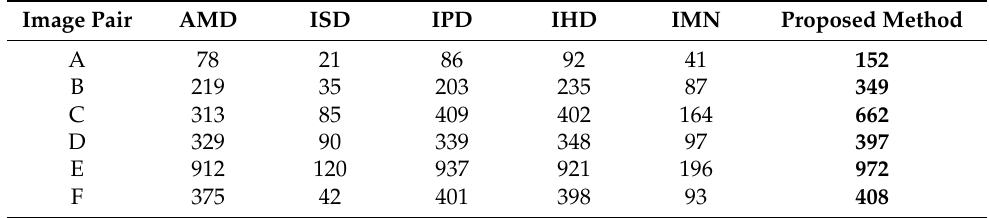
Table 5. Number of correct correspondences obtained by the AMD, ISD, IPD, IHD, IMN, and proposed method based on six groups of stereo images. Bold font denotes the best results.